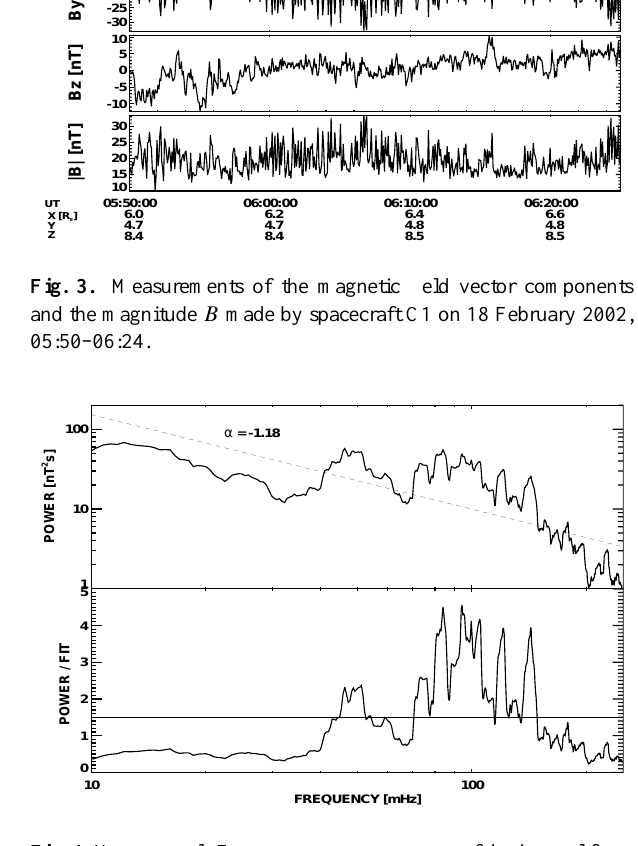
Fig. 4. Upper panel: Frequency power spectrum of the interval from 05:50 to 06:24 on 18 February 2002. The dashed line represents the linear fit of the spectrum. The lower panel displays the ratio of the power spectrum and the linear